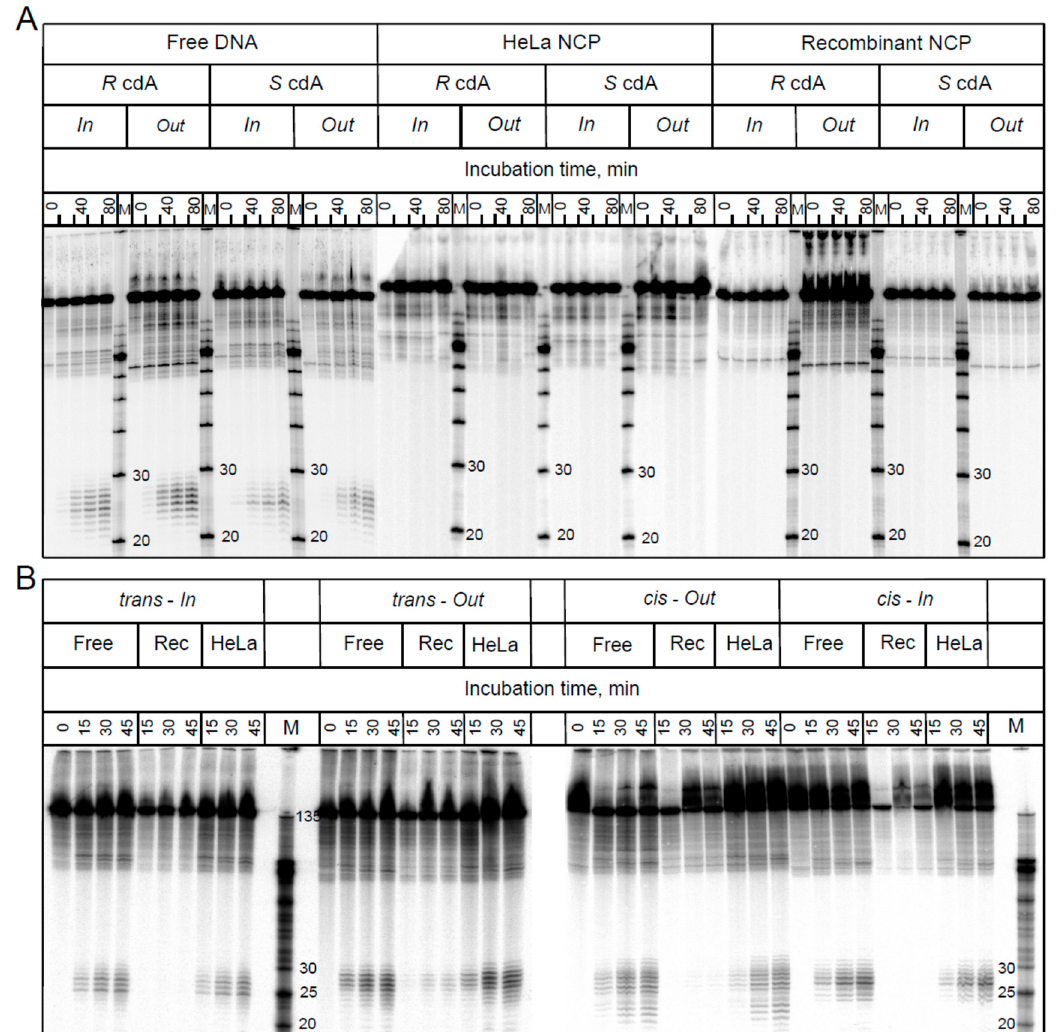
Figure 7. Representative autoradiographs of denaturing gels of the results of nucleotide excision experiment assays in HeLa cell extracts. ( A ) The substrates were either free 147-mer 601 cP DNA sequences containing single cPu lesions or nucleosomes assembled with histone octamers derived from recombinant (Rec) histones or native, post-translationally modified histones extracted from HeLa cells. ( B ) Analogous nucleotide excision repair (NER) experiments with cis - and trans -B[a]PDE-dG adducts positioned at the same In and Out superhelical locations. Three separate gels are depicted in panels A and B. Reproduced from reference [66].